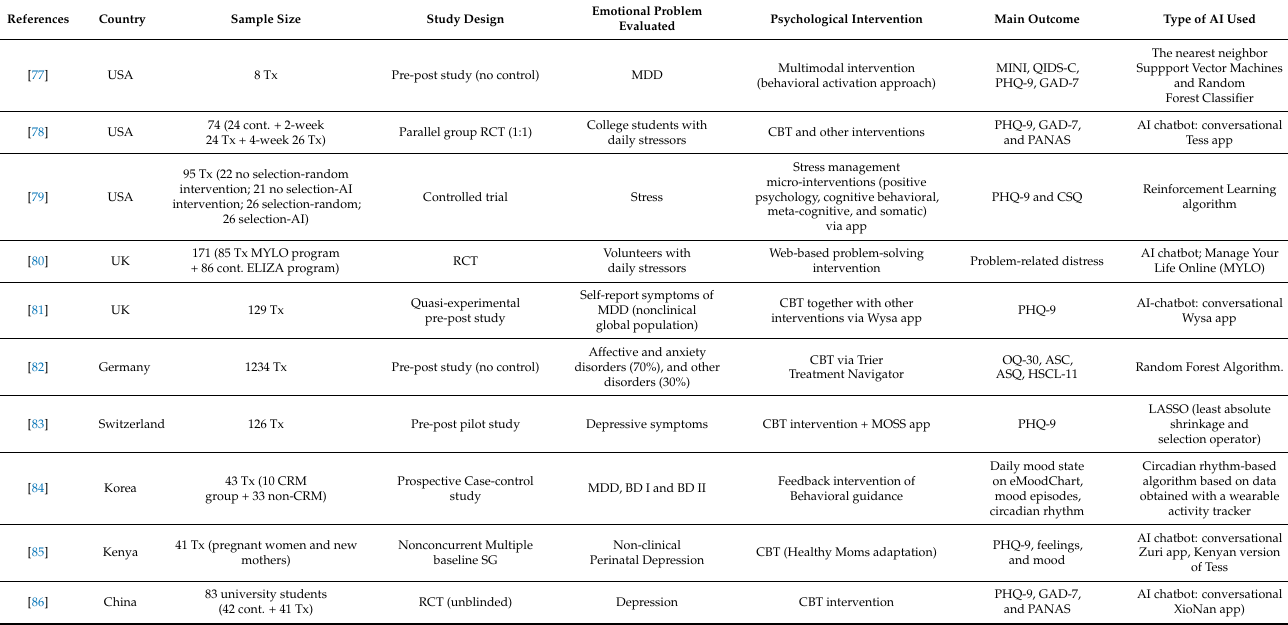
Table 1. Characteristics of the included